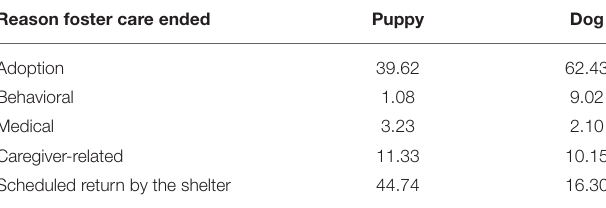
TABLE 6 | Proportion of foster care returns by reason and fostering type. Reason foster care ended